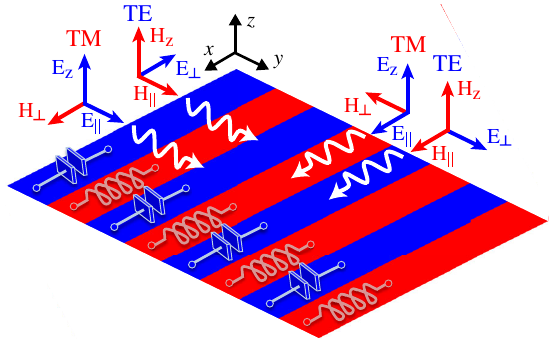
FIG. 3. Geometry of the problem constituted by a collections of coplanar inductive and capacitive parallel strips of a width that is small in terms of a wavelength immersed in free space. The polarization of TE and TM surface-wave modes with a propagation direction both parallel and orthogonal to the strips is also